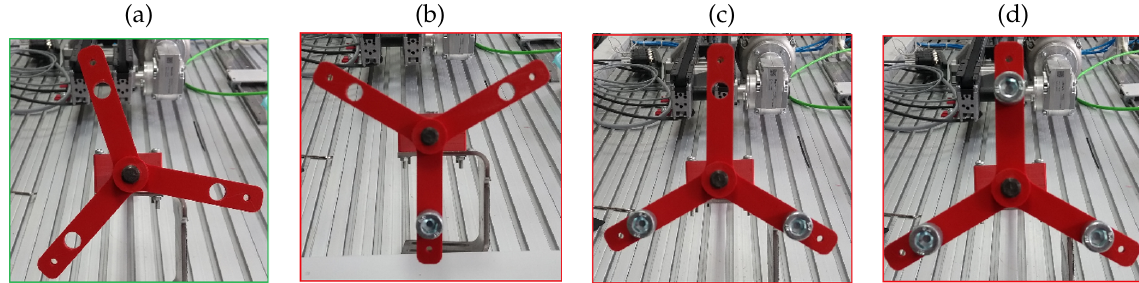
Figure 5. Load distrubution on propeller’s bladess: ( a ) normal state, ( b ) unbalanced with a single mass, ( c ) unbalanced with double mass, ( d ) balanced with extra mass at every blade.